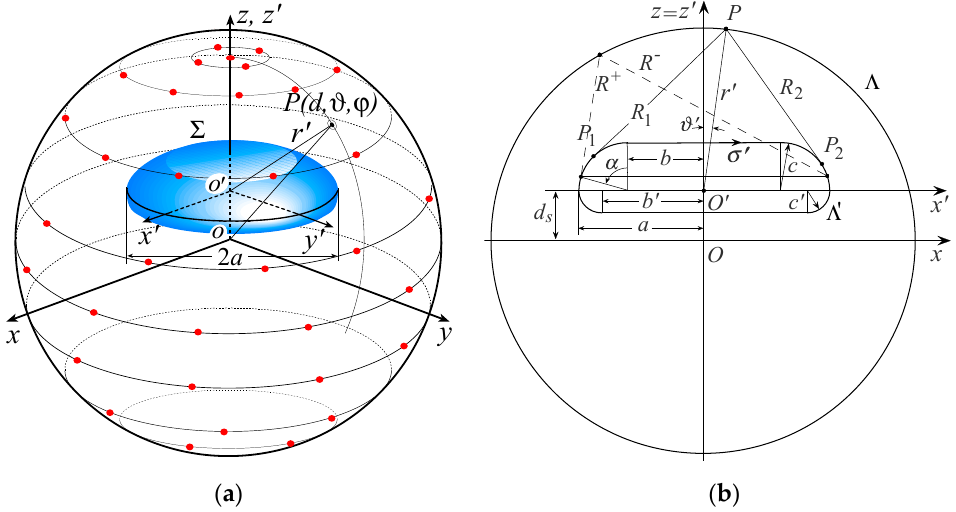
Figure 1. Spherical scan for non-centered quasi-planar antenna under test (AUTs): ( a ) effective modeling of the AUT through a two-bowls; ( b ) relevant to the parameters describing the two-bowls.